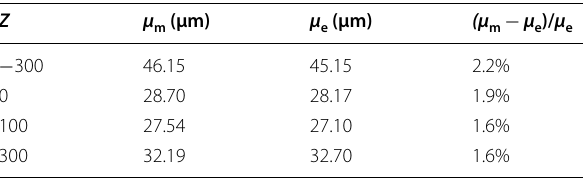
Table 5 The mean and standard deviation of geometric error